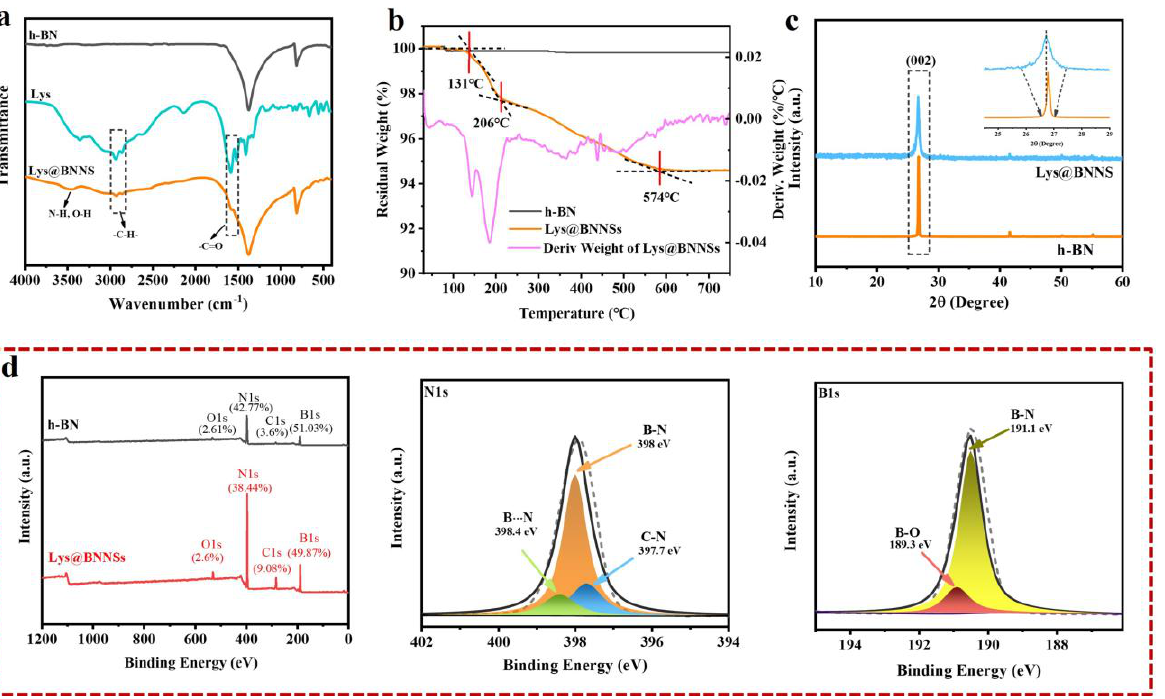
Figure 2. ( a ) FT-IR spectra of h-BN, Lys, and Lys@BNNSs. ( b ) TGA curves of h − BN and Lys@BNNSs and DTG curves of Lys@BNNSs. ( c ) XRD patterns of h-BN and Lys@BNNSs. ( d ) High-magnification XPS survey spectra of h-BN and Lys@BNNSs, XPS survey spectra N1s and B1s of Lys@BNNSs, and corresponding peak-fitting